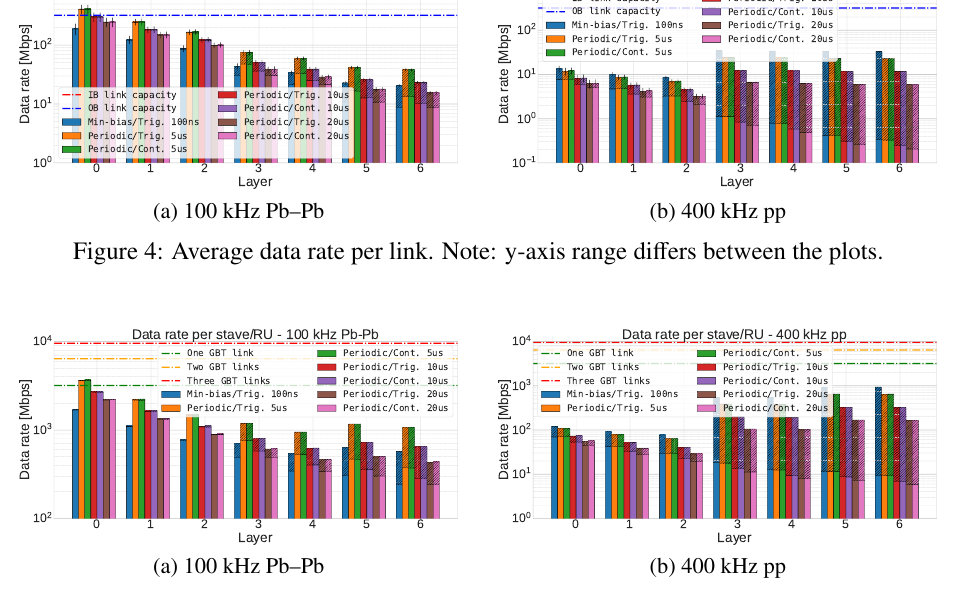
Figure 5: Total data rate per stave / RU. Note: y-axis range di ff ers between the plots. The data rate is shown versus layer for the combinations of trigger and strobe parameters that were simulated. The legend of the figures indicate trigger type first (minimum-bias or periodic), chip mode (triggered or continuous), and finally strobe length and trigger period